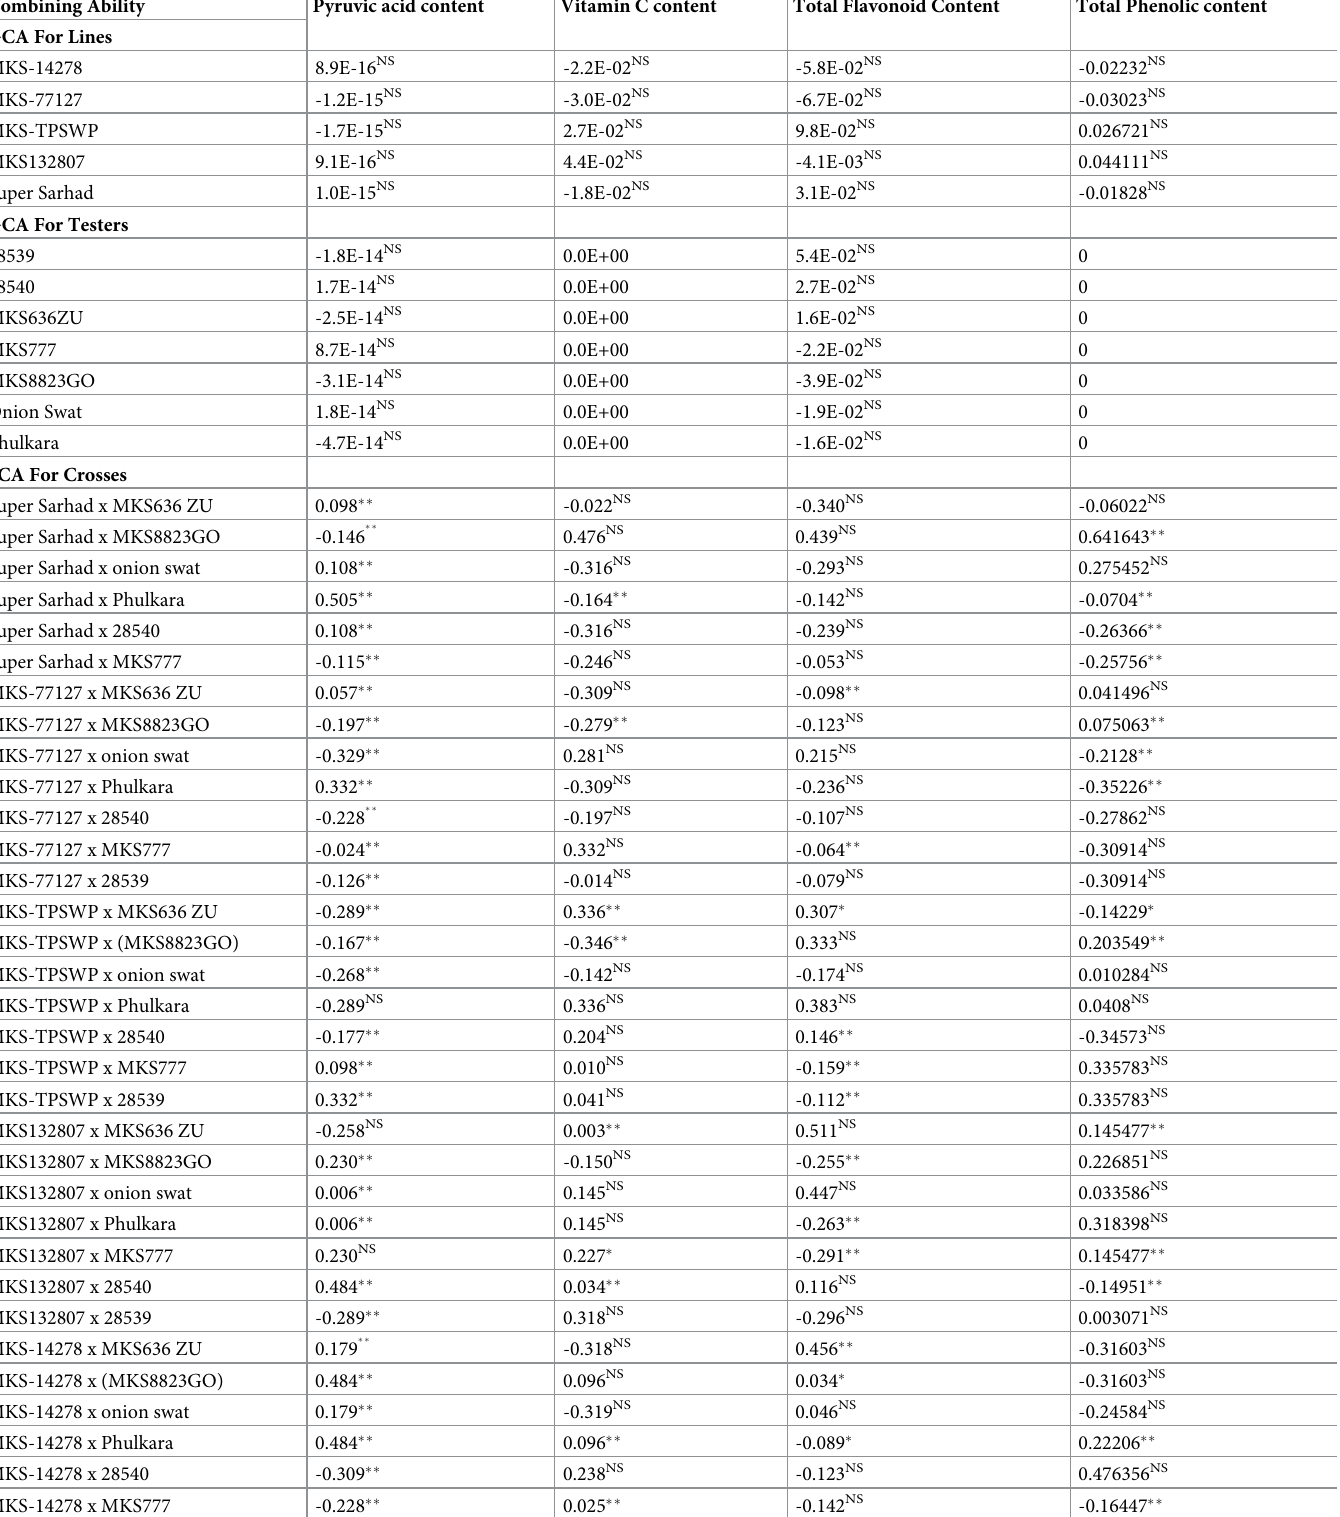
Table 5. Estimates of general combining ability (GCA) and specific combining ability (SCA) effects of parents for 4 different traits based on Line × Tester in